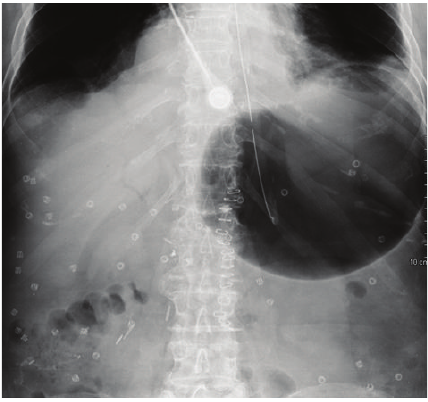
Figure 3: Plain film prior to contrast administration showing stomach distension.